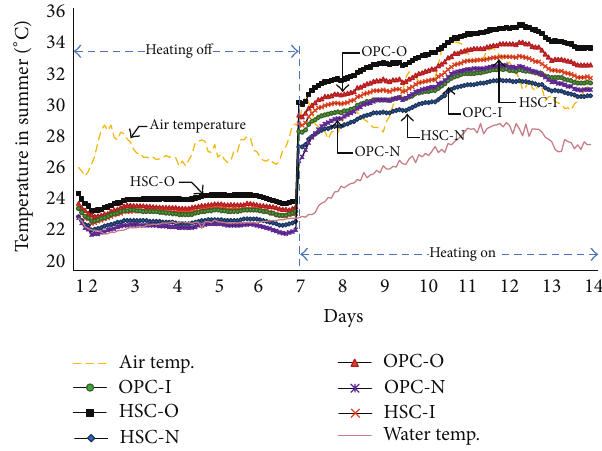
Figure 9: Measurement results of the interior temperature in summer.